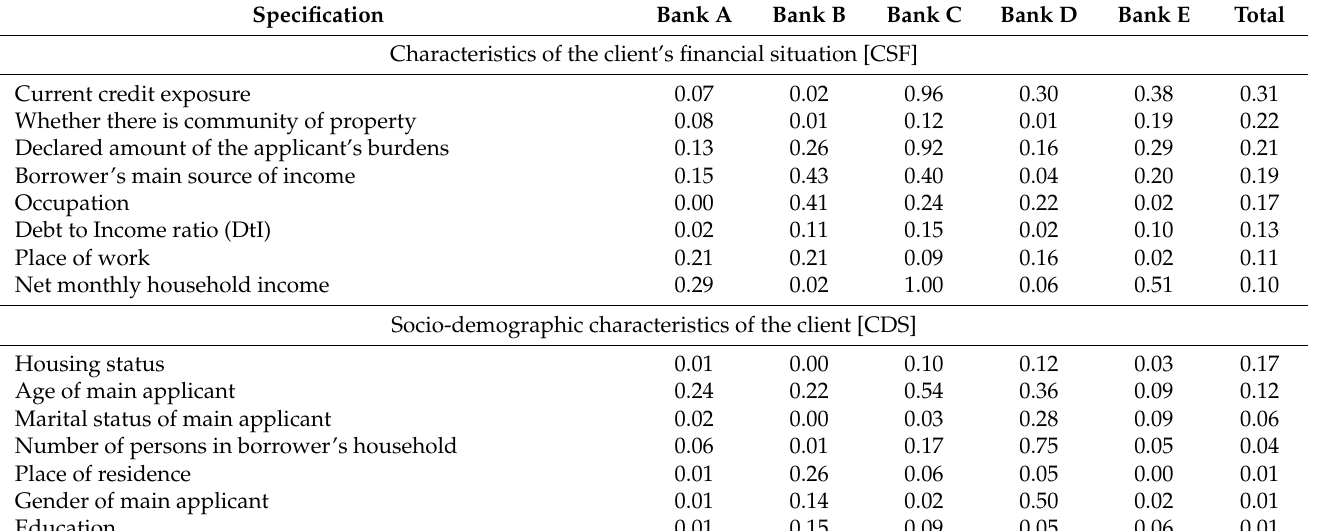
Table 2. Information value index values for the studied traits.